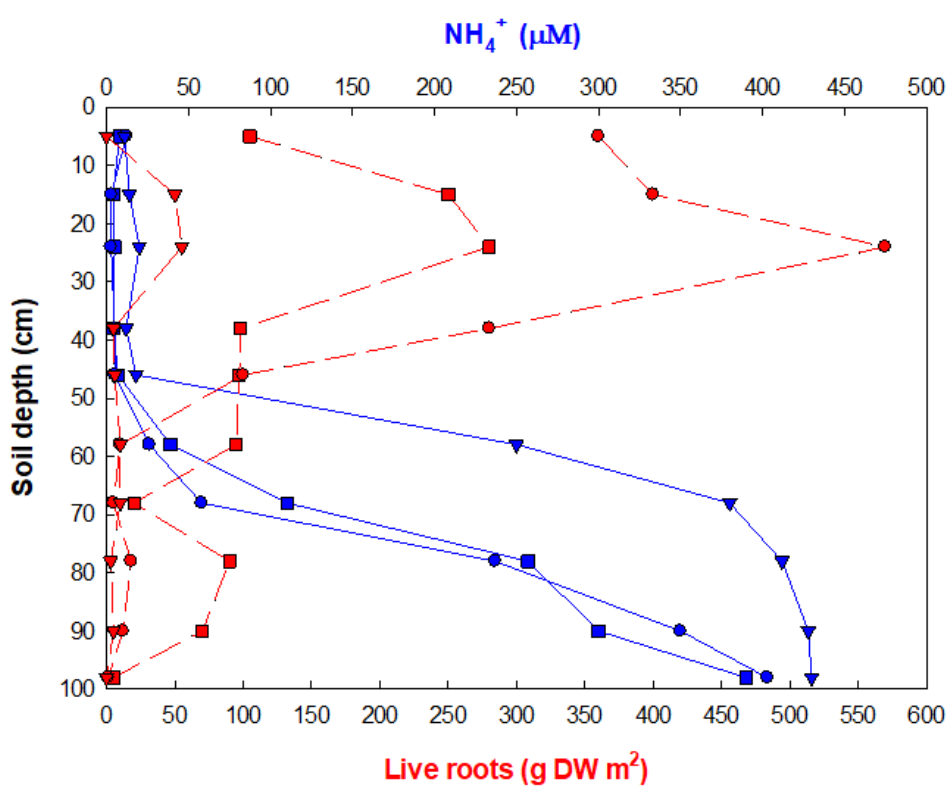
Figure 1. Vertical profiles of porewater extractable ammonium (NH 4 + , µ M) compared with live root biomass (g dry weight m 2 ) in three Kandelia candel forests in the Jiulongjiang estuary, China [9].